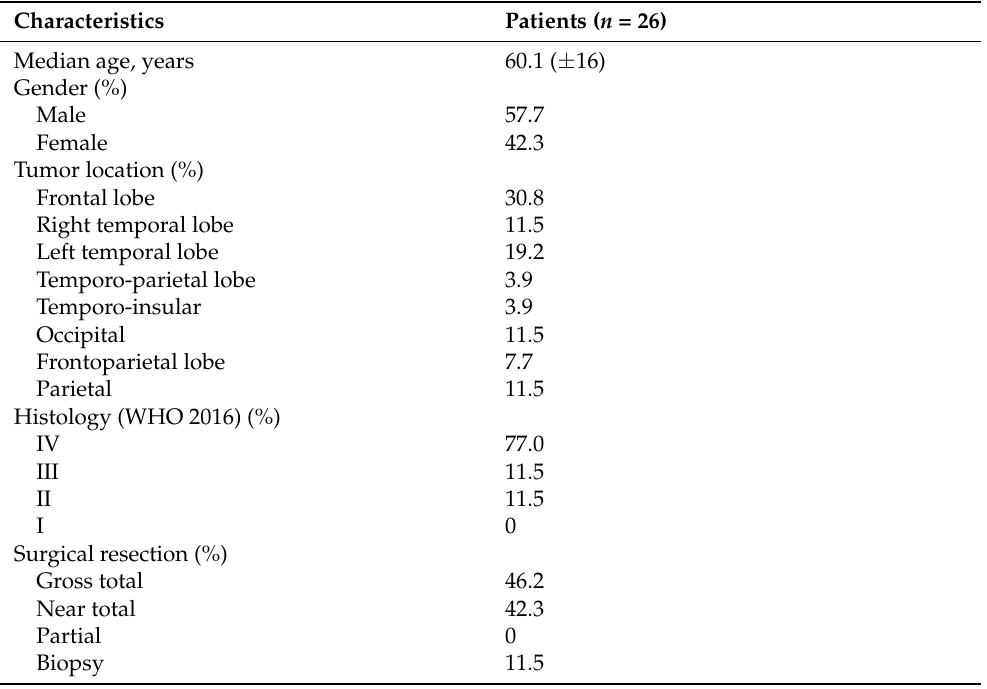
Table 1. Baseline characteristics of the adult glioma cohort enrolled in the study.